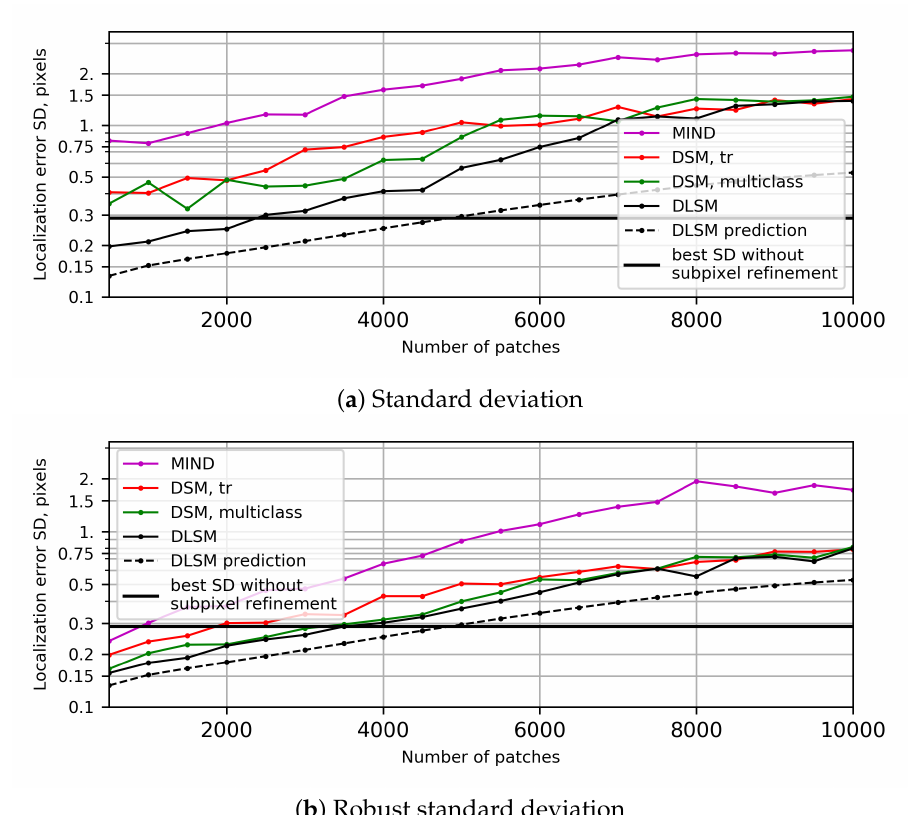
Figure 10. Localization error vs. The number of